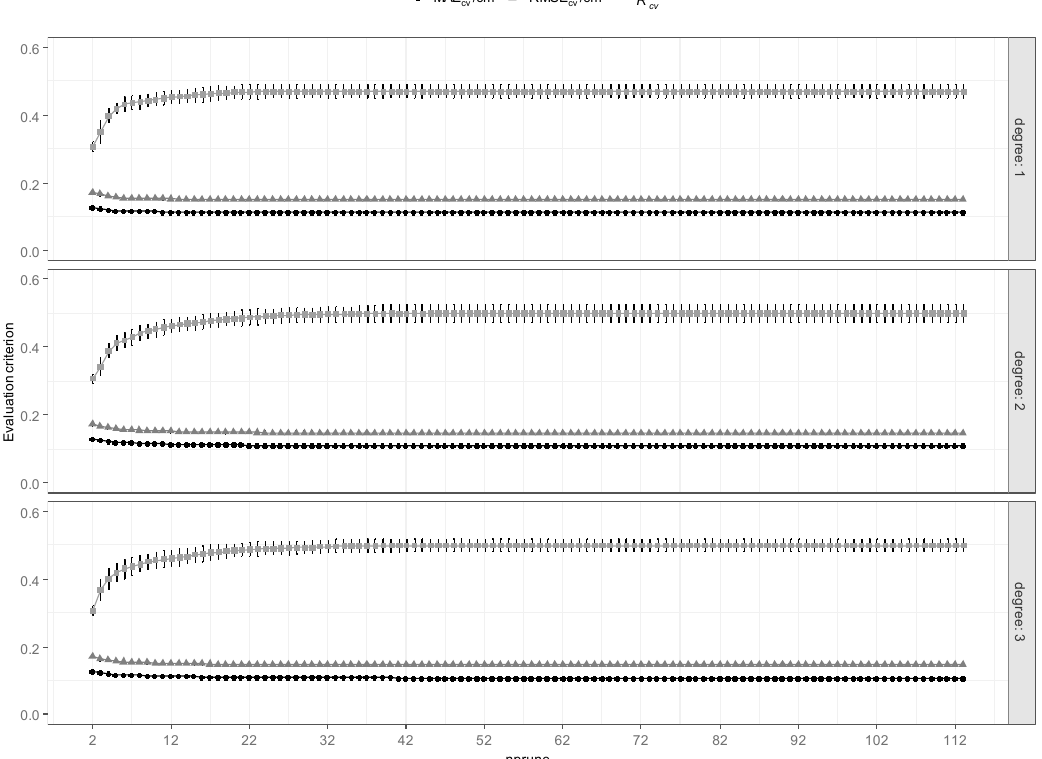
Figure 4. Tuning multivariate adaptive regression splines (MARS)—the effect of degree and nprune on MARS model performance. The tenfold cross-validation was used for validating. The error bar is standard deviation. The parameters, degree and nprune, are the maximum degree of interaction and the maximum number of terms (including intercept), respectively.